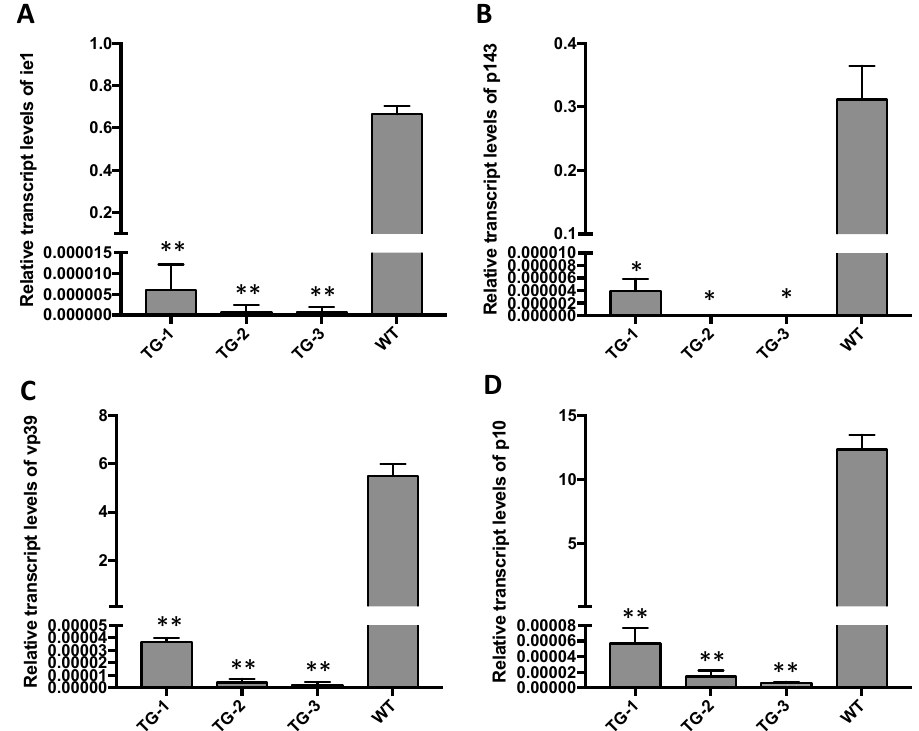
Figure 6. Expression levels of different-phase BmNPV genes in transgenic and WT silkworms. The relative transcript levels of ( A ) ie-1 , ( B ) p143 , ( C ) vp39 , and ( D ) p10 were determined by qRT-PCR in transgenic larvae and wildtype larvae treated with 10 6 OBs/larva at 72 hpi. Data represent the means ± SEM. * p < 0.05; ** p < 0.01 by one-way ANOVA.